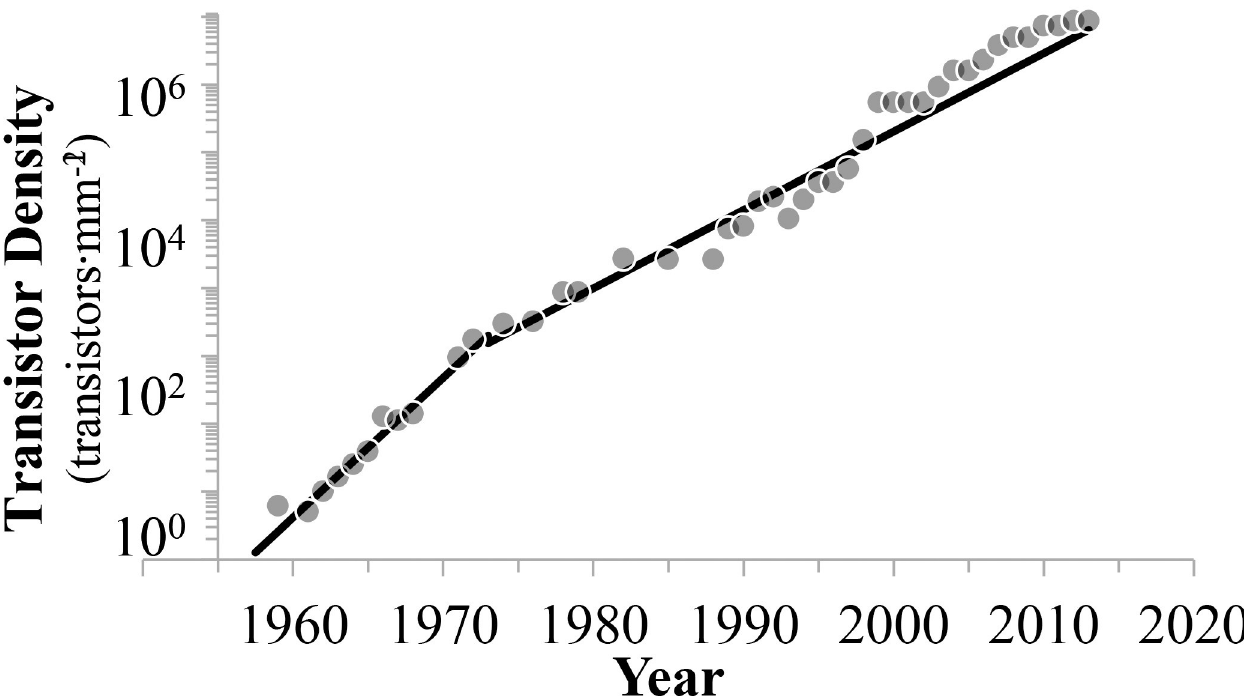
Fig 3. State-of-the-art integrated circuit density (transistors � mm -2 ) per year. The two exponential growth phases are characterized by doubling times of 17 and 33 months, respectively. Data are heteroscedastic and autocorrelated, consistently underestimating all data since 1999.